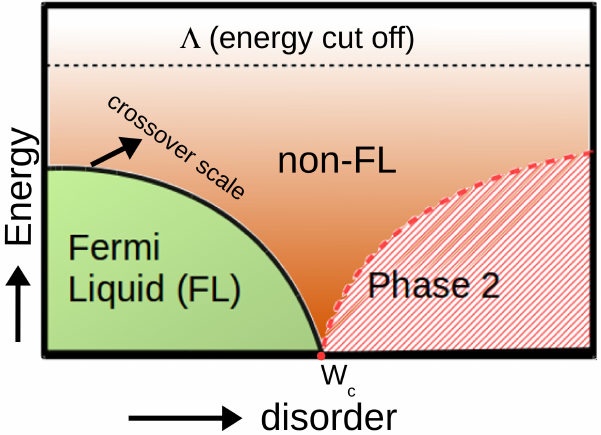
Figure 44. A schematic phase diagram in the disorder-energy plane of the Anderson-Hubbard model showing a disorder-driven QCP separating a Fermi liquid from an as yet unidentified Phase-2. Reprint from